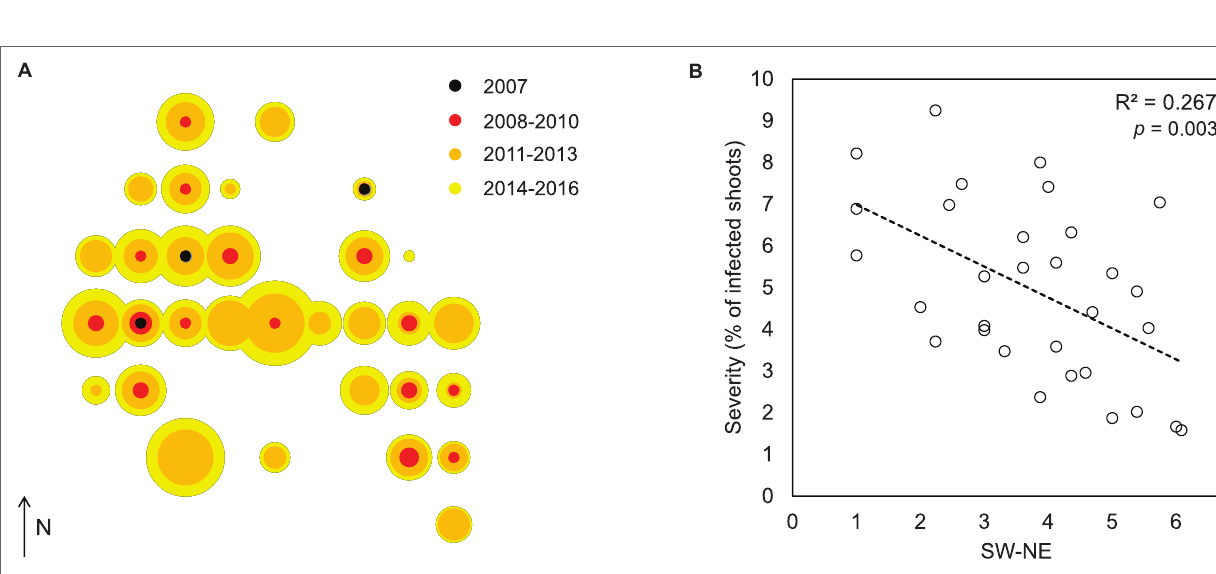
( Figure 5B ). Heavily defoliated trees were characterized by displaying consistently lower δ 13 C values irrespective of whether the year had a warm or cold spring ( Figure 5C ). Defoliated trees had lower NSC concentrations in needles and branch sapwood during the winter after the outbreak ( Figure 5D ), but no differences were found in root NSCs.